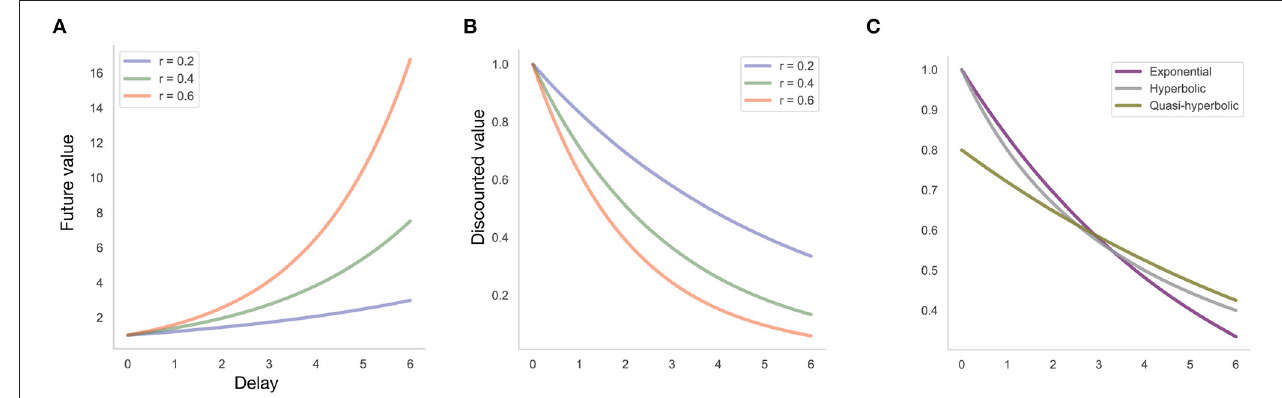
FIGURE 1 | Individual differences in discount functions. (A) Future value of $1 received today with exponential discount function at different discount rates r , that is, the value of an amount received after a given delay that is equivalent to $1 received today. This is the amount at which a decision-maker with a given discount function is indifferent between receiving this amount at a given delay, and $1 received today. (B) Discounted value of $1 received at a given delay, assuming an exponential discount function with discount rate r , that is, the value to the decision-maker today of $1 received at a given delay. (C) Discounted value of $1 received at a given delay, assuming different discount functions (exponential function with discount rate r = 0.2, hyperbolic discount function with discount rate k = 0.25, quasi-hyperbolic discount function with parameters β = 0.8, δ =